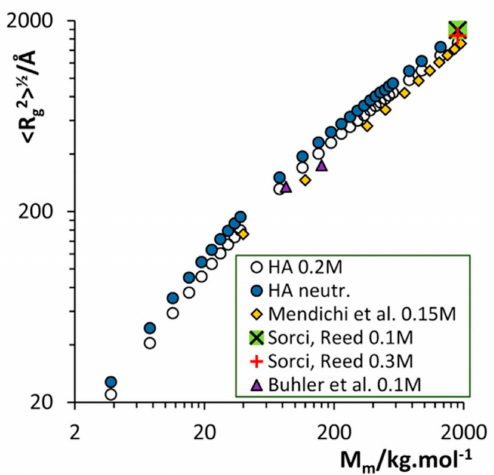
Figure 3. Radii of gyration (R g ) of modeled hyaluronan random coils of varying molecular mass (M m ) constructed using data from molecular dynamics simulations with either 0.2 M NaCl (white circles) or neutralizing sodium (blue circles) as compared to various experimental data (other symbols; see [118] for references to experimental data). Reprinted with permission from Ref. [118]. Copyright 2017